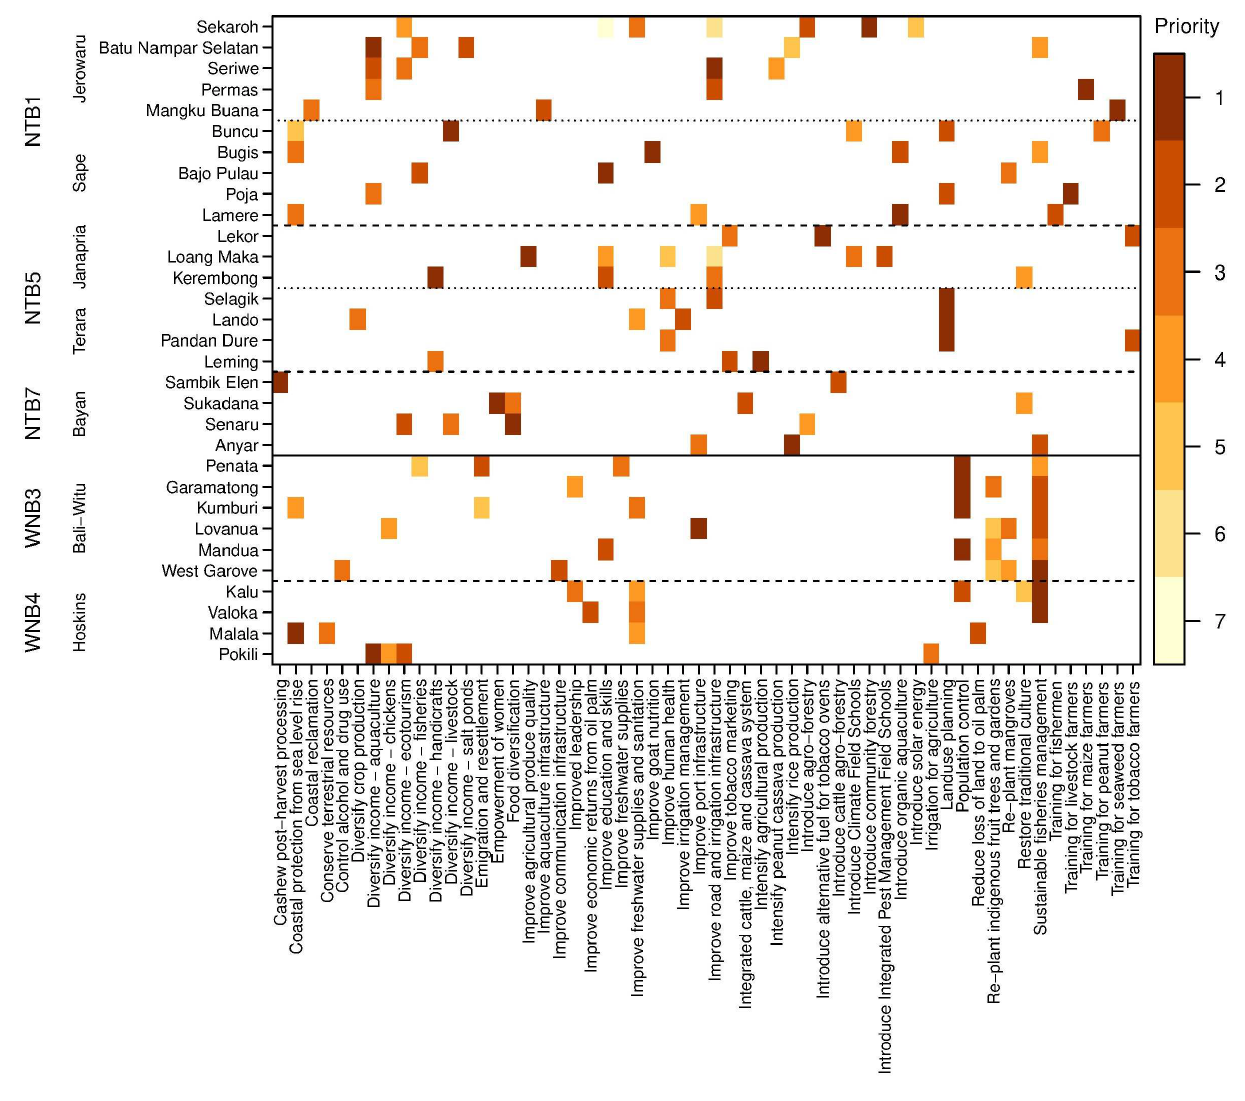
FIGURE 5 | The 56 adaptation strategies designed for each village, and their priority. Villages are grouped by sub-district